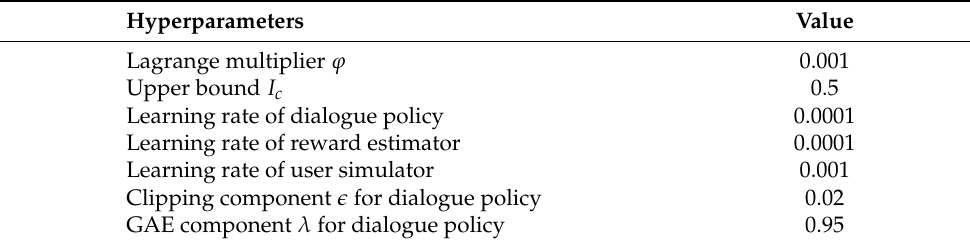
Table 1. Detail description of VRB